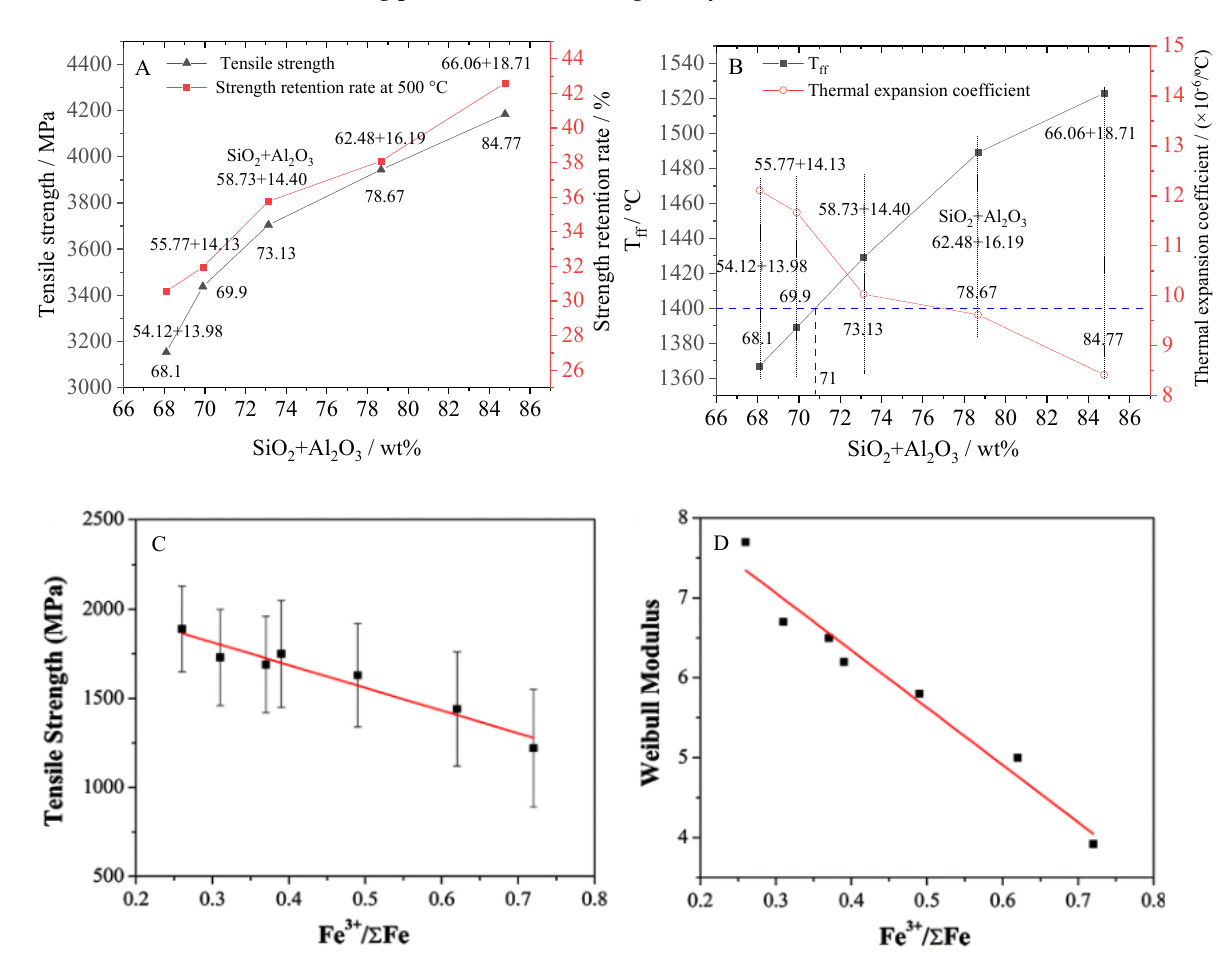
Figure 3. Effect of main chemical composition on the mechanical properties and thermal stability of the BCFs. ( A ) The effect of the total content of SiO 2 and Al 2 O 3 on the tensile strength of the BCFs and its strength retention rate at 500 ◦ C. ( B ) The effect of the total content of SiO 2 and Al 2 O 3 on the T ff and the thermal expansion coefficient of the BCFs; the data of ( A , B ) from (Liu et al., 2017). ( C ) The relationship curve between the Fe 3+/ Σ Fe and tensile strength of single continuous fiber (Xing et al., 2019). ( D ) The relationship curve between the Fe 3+/ Σ Fe and Weibull modulus of the single continuous fiber (Xing et al., 2019).